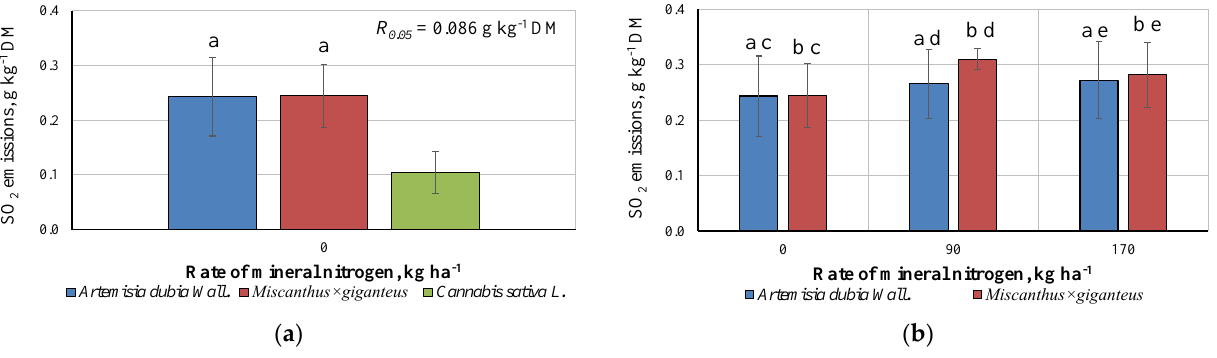
Figure 11. The dependence of SO 2 emissions of Artemisia dubia Wall., Miscanthus×giganteus and Cannabis sativa L. not fertilized ( a ), on mineral nitrogen fertilization ( b ) ( R 0.05 ( A. dubia ) = 0.104 g kg −1 DM, R 0.05 ( M. giganteus ) = 0.074 g kg −1 DM, R 0.05 ( A. dubia × M. giganteus ) = 0.071 g kg −1 DM. a, there are no statistically significant differences ( p < 0.05) between the columns marked with the same letter, as assessed using the least significant difference.